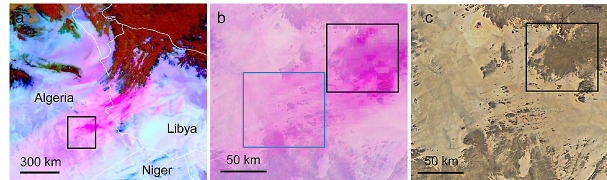
Fig. 13. (a) Dust uplift in northern Iraq. Black arrow indicates the source area. (b) The area of dust uplift shown on a surface re- flectance image overlaid by SEVIRI RGB image with individual pixels seen as rectangles. (c) True-colour surface reflectance image showing multiple potential dust sources (agricultural fields, season- ally river beds) in the same area as on (b)